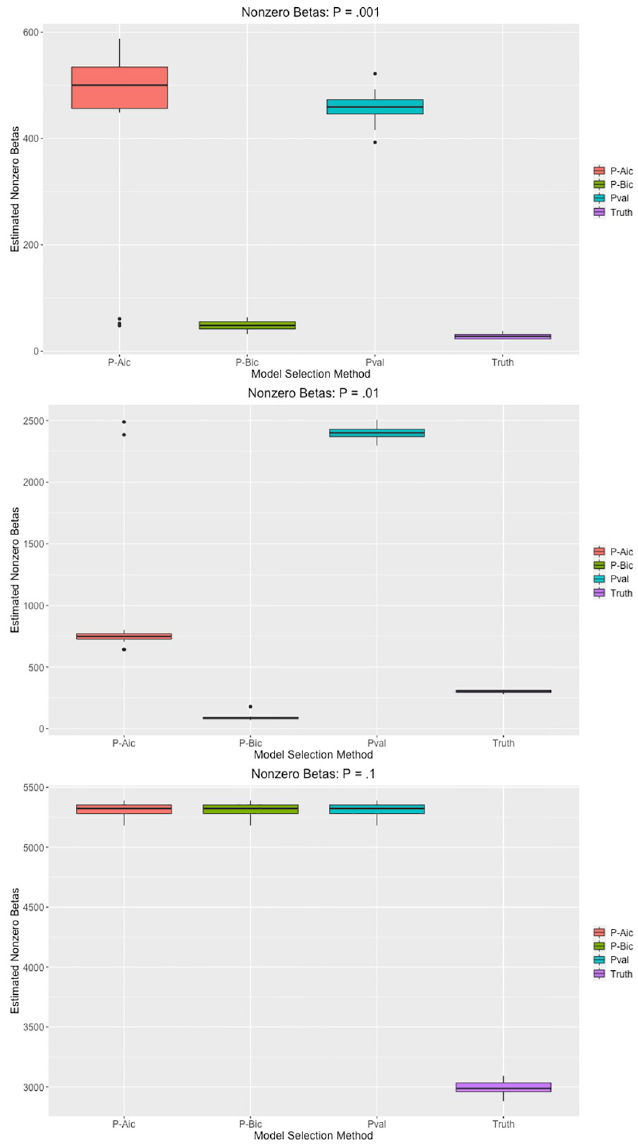
Fig 10. Number of estimated nonzero effects for each model selection method across each of the simulation settings in simulation 1. Models were selected from a set of candidate LassoSum models.